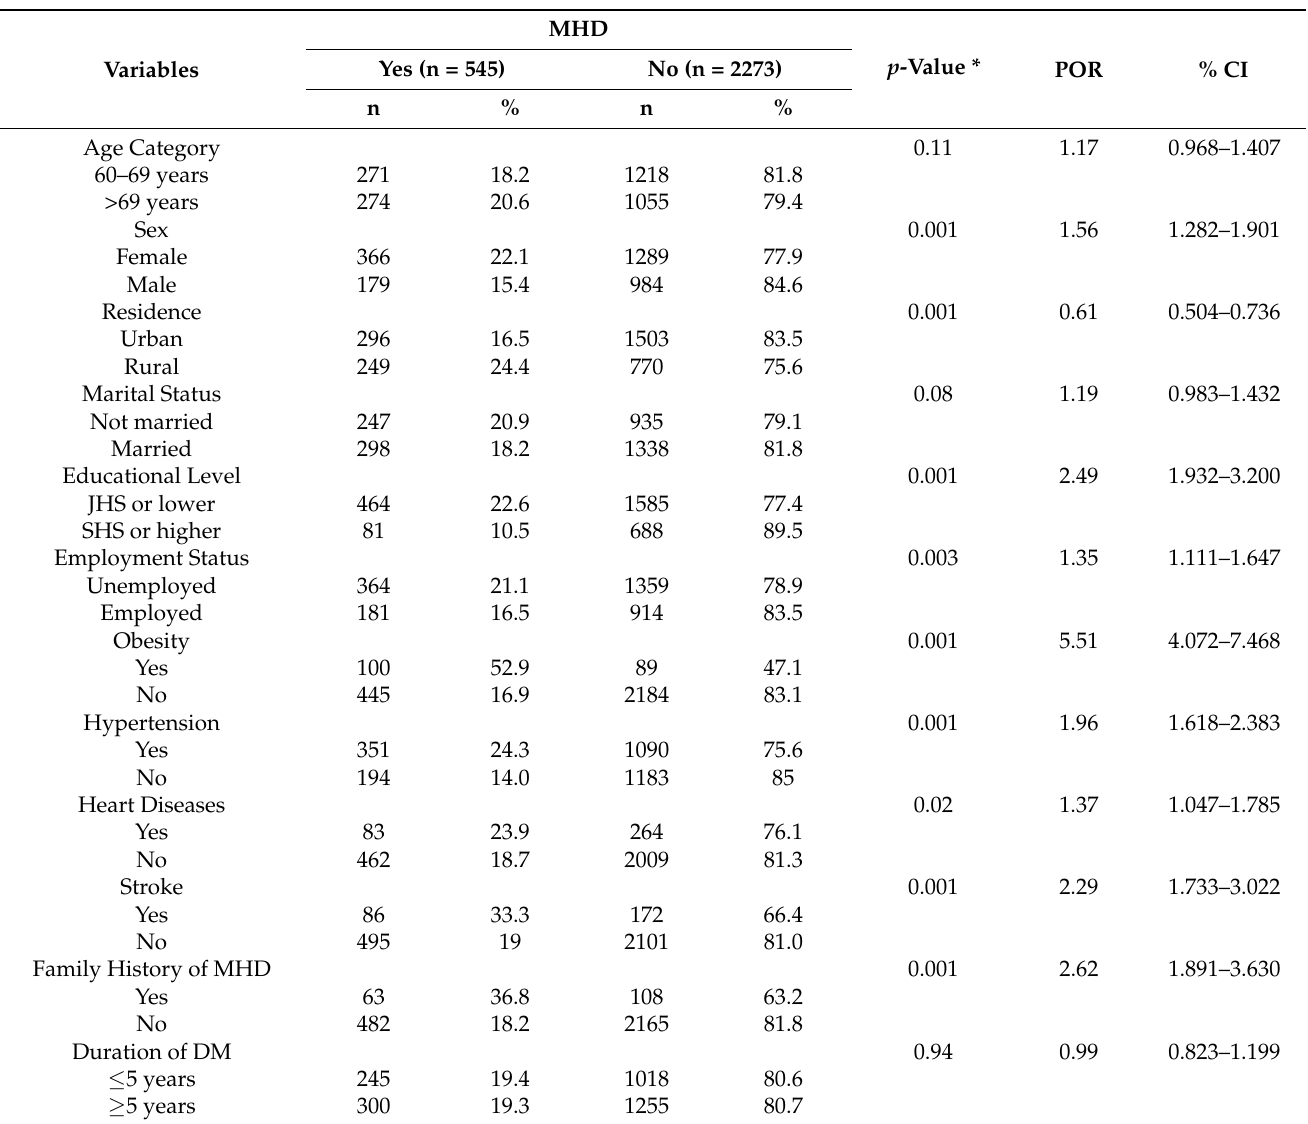
Table 2. Subjects’ characteristics based on MHD